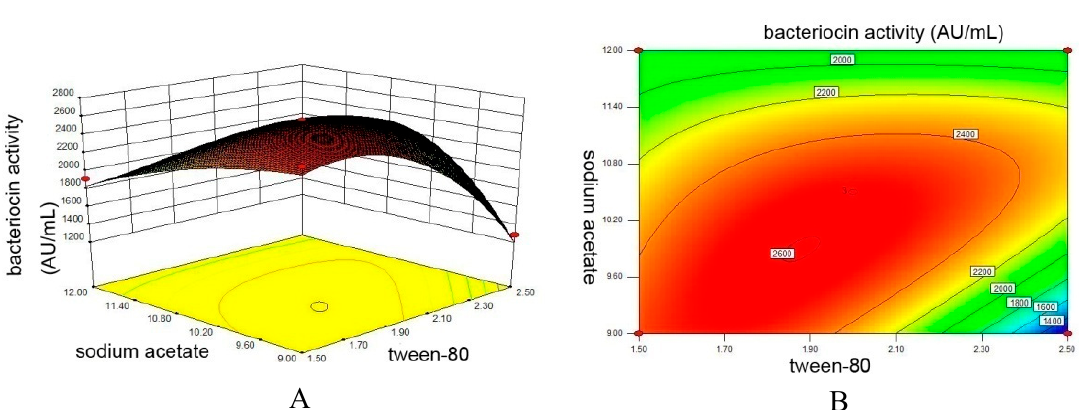
Figure 2. Response surface plot ( A ) and contour plot ( B ) of bacteriocin Lac-B23 production. Values listed are the averages of three experiments.